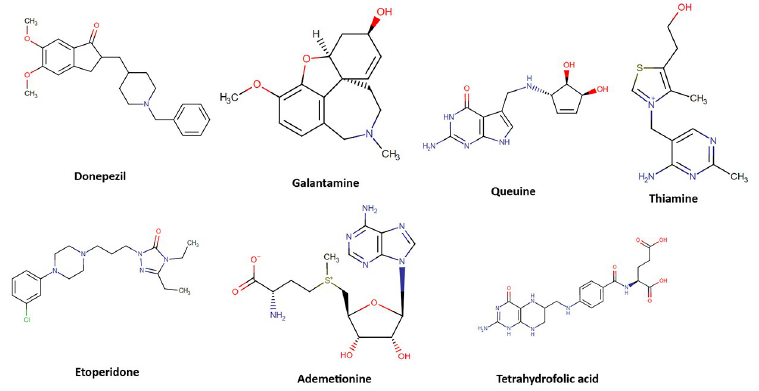
Fig 1. Chemical structures of Donepezil, Galantamine and five hit natural molecules investigated in this work as potential AChE inhibitors.